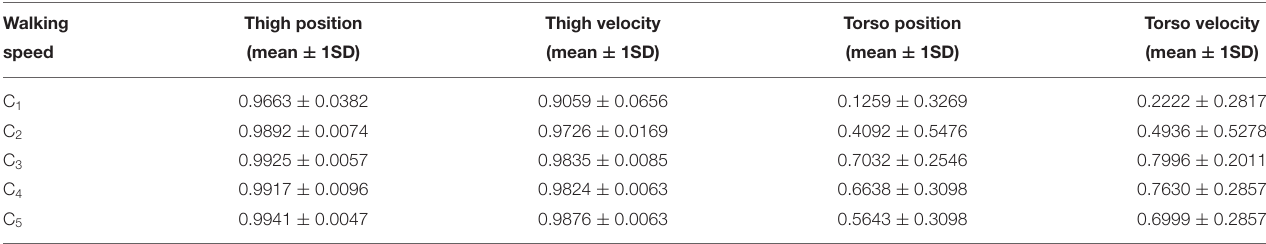
TABLE 1 | Mean and SD of correlation coefficients for each dataset in five different speed conditions. Walking Thigh position Thigh velocity Torso position Torso